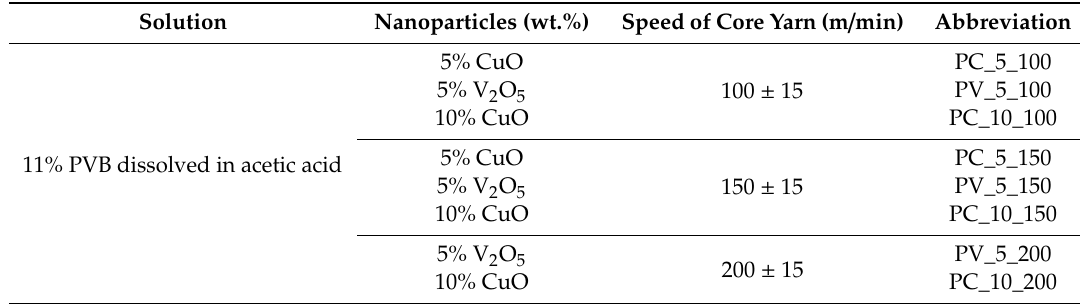
Table 2. Nanofiber / nanoparticle-covered samples.